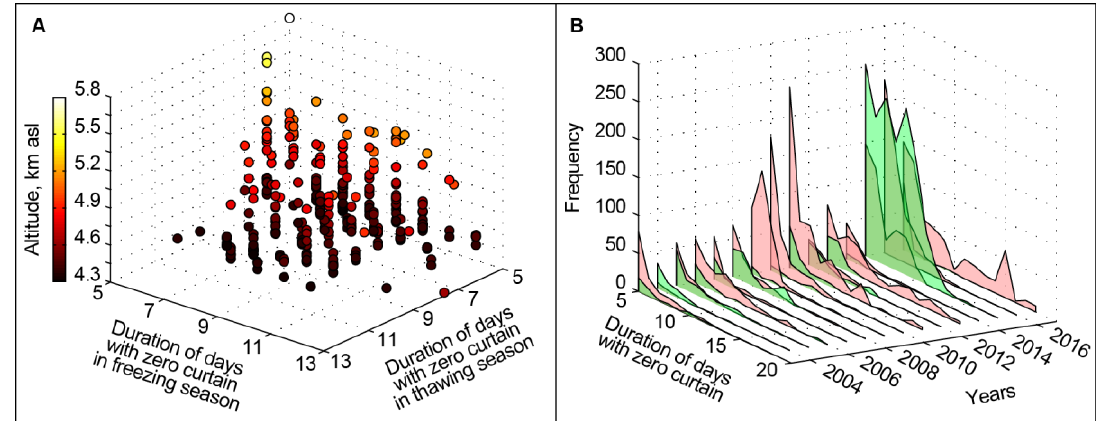
Figure 12. The zero-curtain duration for all pixels in which zero curtains were detected during both freeze-up and thaw. The zero curtain was only recognized for durations of five days or more. ( A ) Versus altitude (2015 only). Two-season zero curtains were not detected below 4300 m asl due to warm temperatures there. Above 5800 m asl, the ground was too cold for persistent thaws. At intermediate altitudes, there was su ffi cient soil moisture for both near-surface freezing and thawing. ( B ) Zero-curtain duration during freeze-up (red) and thaw (green) plotted against the corresponding years.